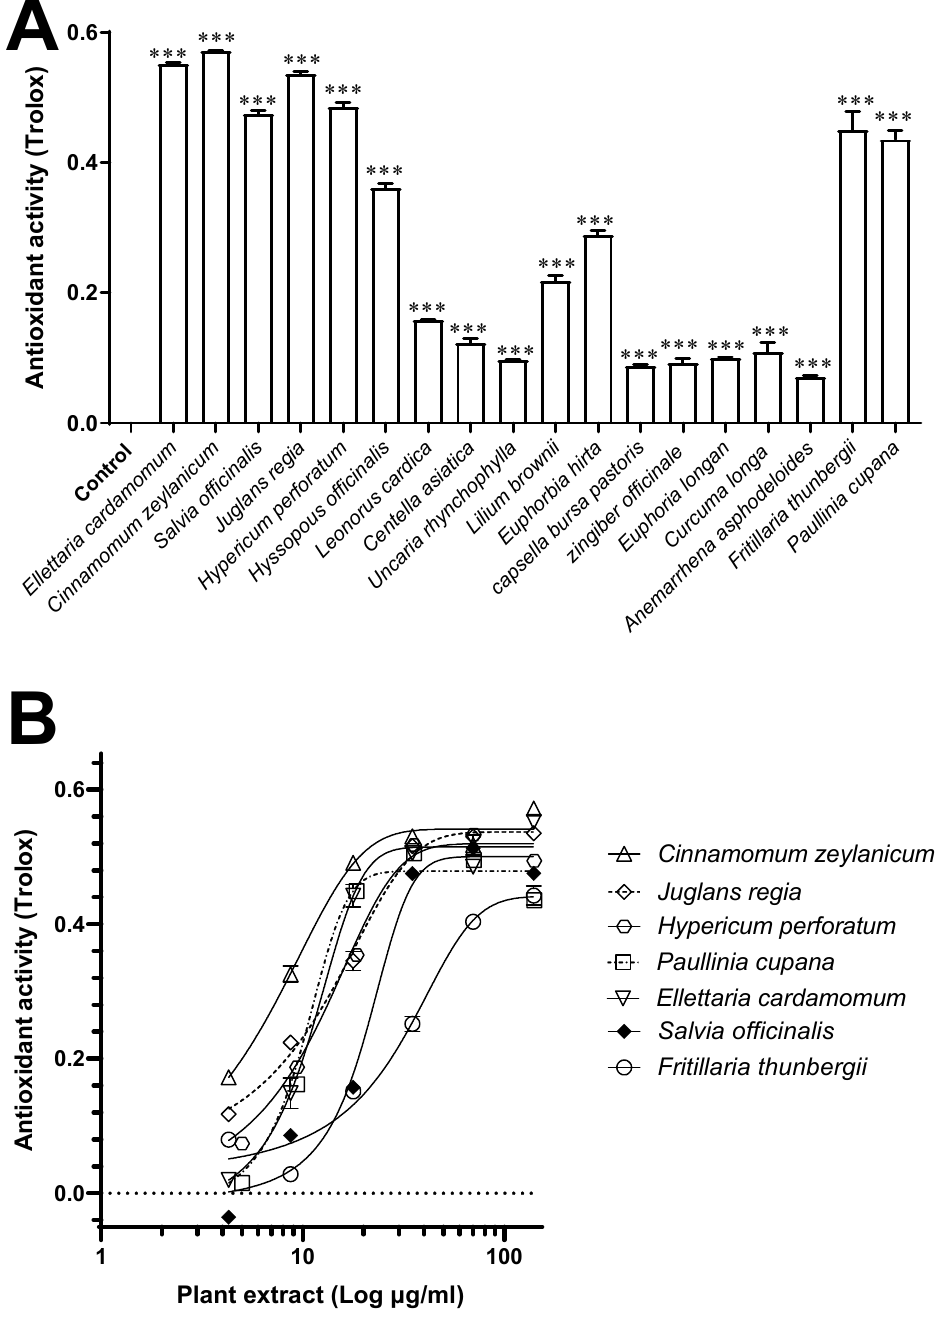
Figure 3. Antioxidant activity of plant extracts. ( A ) Antioxidant activity of plant extracts ( n = 18; 140 µ g/mL) was screened using a commercial ABTS antioxidant activity assay kit, with results interpo- lated against Trolox standard (mM); ( B ) concentration-dependent antioxidant activity (4.3–140 µ g/mL) was then determined for seven selected plants (in order of greatest activity): C. zeylanicum , J. regia , H. perforatum , P. cupana, E. cardamomum , S. officinalis , and F. thunbergii . Data are mean ± SEM ( n = 2). *** p < 0.001 and ns (not significant) compared with the negative control (assay buffer).